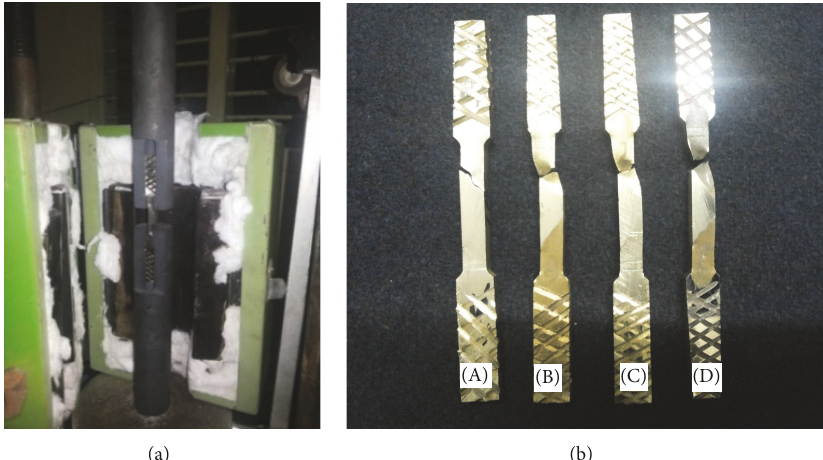
Figure 8: (a) Weldment at the end of 200 ∘ C test. (b) Tested specimens of the weldment at (A) room temperature, (B) 200 ∘ C, (C) 400 ∘ C, and (D) 550 ∘